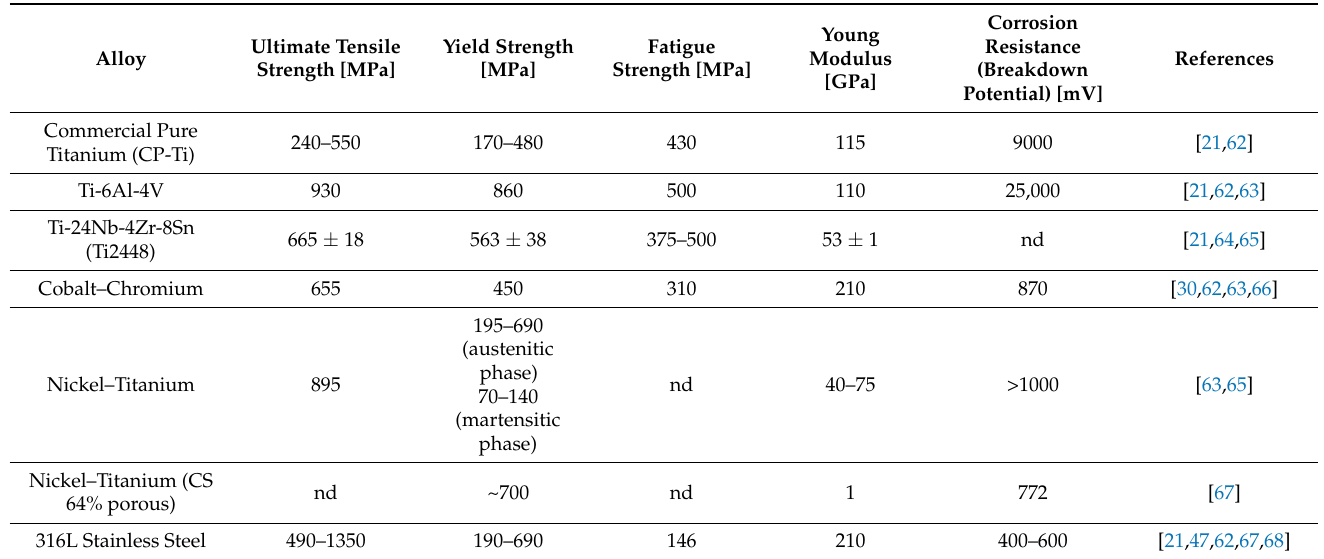
Table 1. Quantitative comparison of mechanical properties of titanium alloys, cobalt–chromium, nitinol alloys, and stainless steel 316 L.